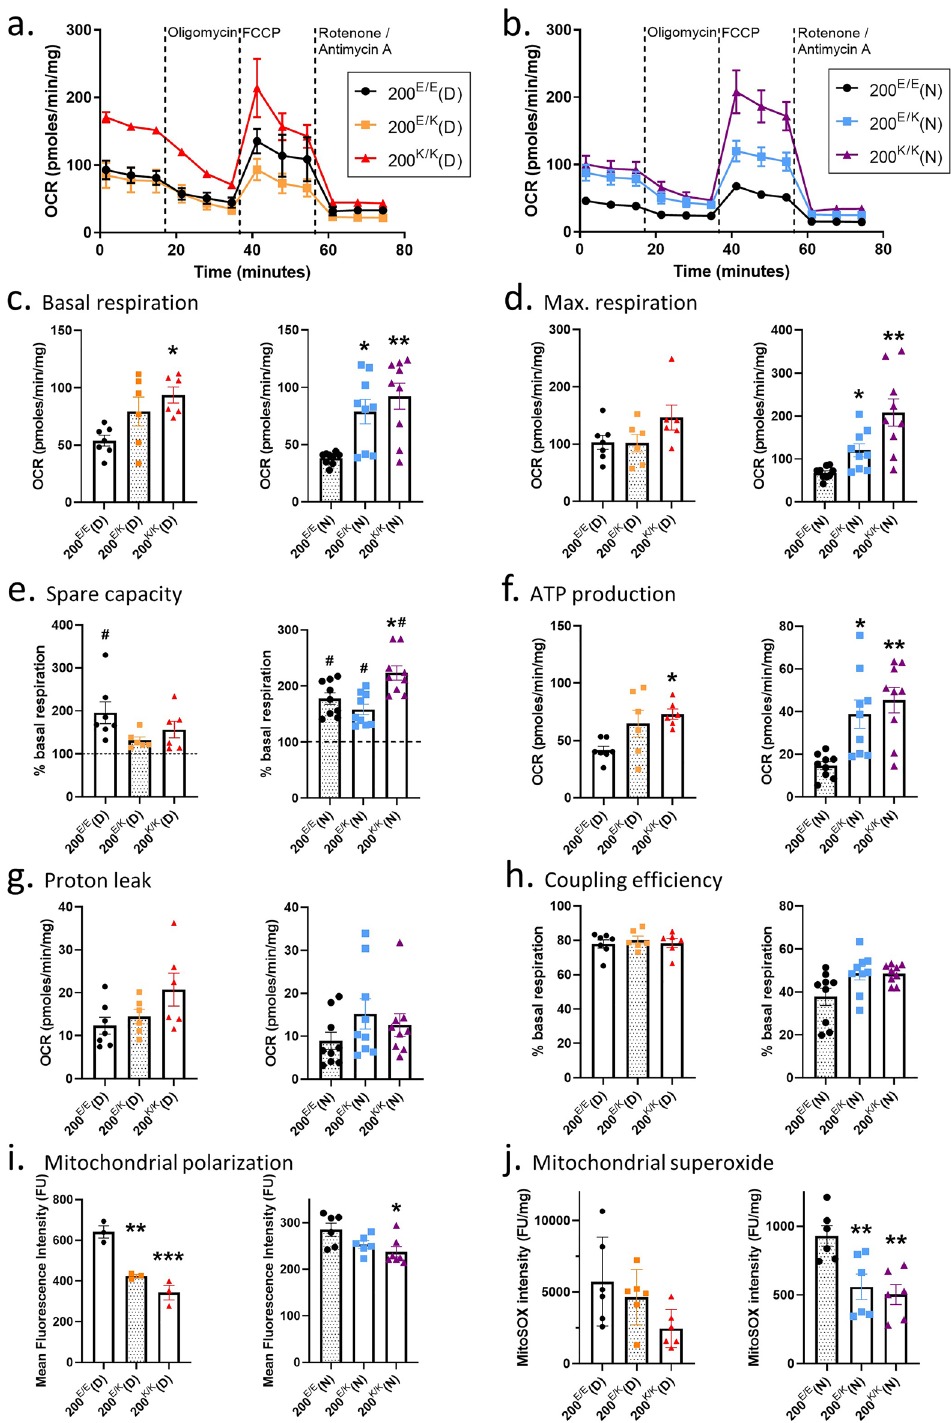
Figure 6. A 200 E/E , 200 E/K and 200 K/K genetically matched cardiomyocytes display altered mitochondrial function. Example traces showing changes in oxygen consumption rates on stimulation or inhibition of the ETC in the 200 E/E , 200 E/K and 200 K/K genetically matched cardiomyocytes from the PRNP E200K donor ( a ) or no known mutation donor ( b ) cells. Traces show the mean and SEM (n ≥ 6). Graphs showing ( c ) basal respiration, ( d ) maximum respiration, ( e ) spare capacity, ( f ) ATP production, ( g ) proton leak and ( h ) coupling efficiency calculated from the experimental setup shown in ( a ). ( i ) Mitochondrial polarization of 200 E/E , 200 E/K and 200 K/K cardiomyocytes shown as mean fluorescence intensity per cell. ( j ) MitoSOX intensity measurements. Except for A & B as described, graphs show data points of each independent biological repeat ‘ n ’ with mean and SEM, *p < 0.05, **p < 0.01, and ***p <